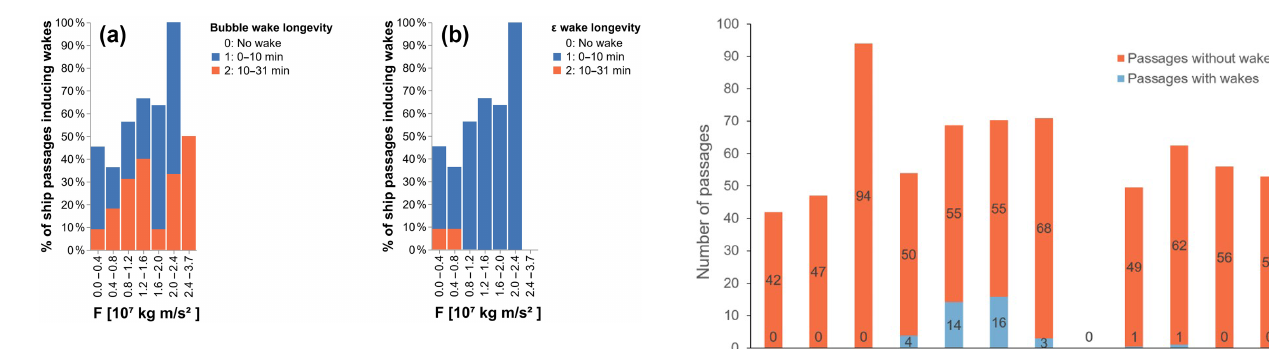
Figure 8. Wake longevity for the bubble wake (a) and dissipation rate of turbulent kinetic energy ( ε) wake (b) , for detected wakes induced by ships passing at zero to three ship widths from the in- strument. The x axis shows the force ( F ) of the vessel in newton. Wake temporal longevities < 10min are shown in blue, and wake longevities 10–31min are shown in orange.